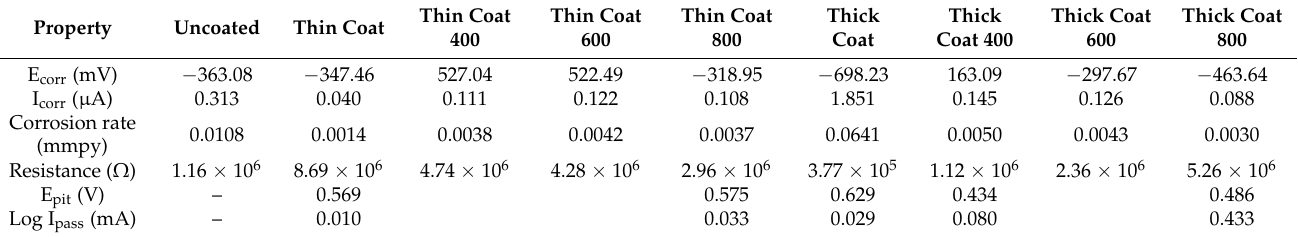
Table 2. Electrochemical properties of HEA with reference to uncoated titanium CP-II.